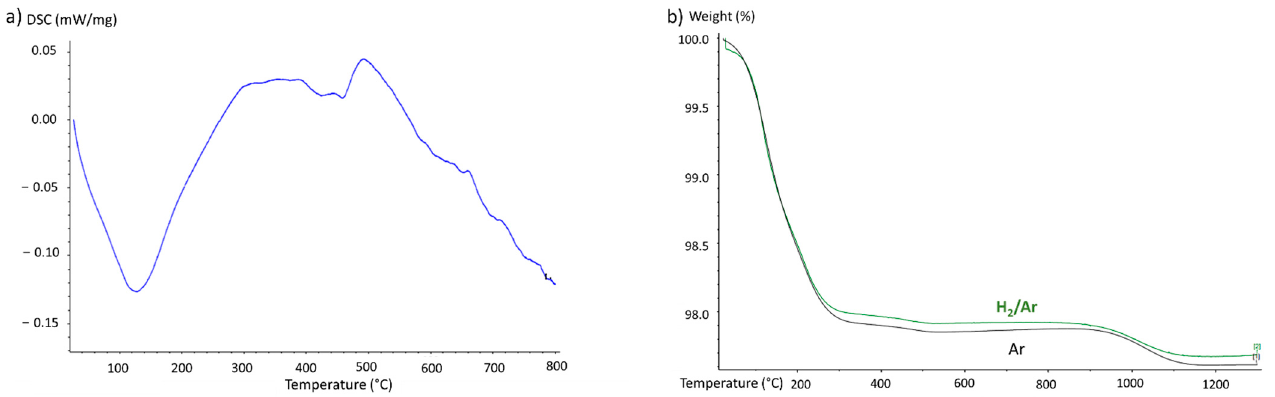
Figure 3. Scanning electron microscope observation of WmoTaNb powder in backscattered electrons.